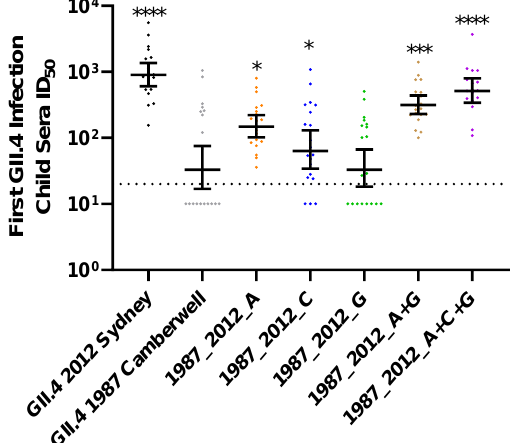
Figure 2. GII.4 Sydney infection in young children induces nAb responses to multiple overlapping antigenic sites. Sera from children ( n = 20) with an RT-qPCR confirmed first symptomatic GII.4 infection, typed as GII.4 2012 Sydney, were evaluated for nAb titer to GII.4 2012 Sydney, GII.4 1987 Camberwell, and antigenic site chimera VLPs comprised of GII.4 2012 Sydney epitopes in the backbone of GII.4 1987. Y-axis: reciprocal of the serum dilution at 50% inhibitory dose. Marker: individual child. Line: geometric mean titer. Error bars: 95% confidence intervals. Dashed line: limit of detection. * p = 0.02, *** p = 0.0001, **** p < 0.0001 compared to GII.4 1987 Camberwell.